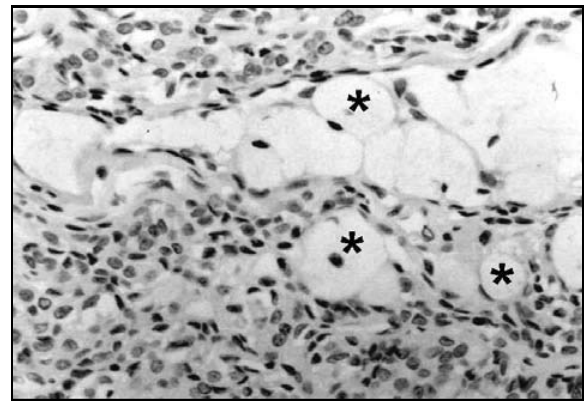
AP: adenoma pleomórfico; CAC: carcinoma adenóide cístico; CM: carcinoma mucoepidermóide. Grupos em que a média de imunomarcação foi significativamente diferente. Figura 3 – Distribuição de neoplasias primárias de glândula salivar segundo o tipo histológico e o índice de imunomarcação